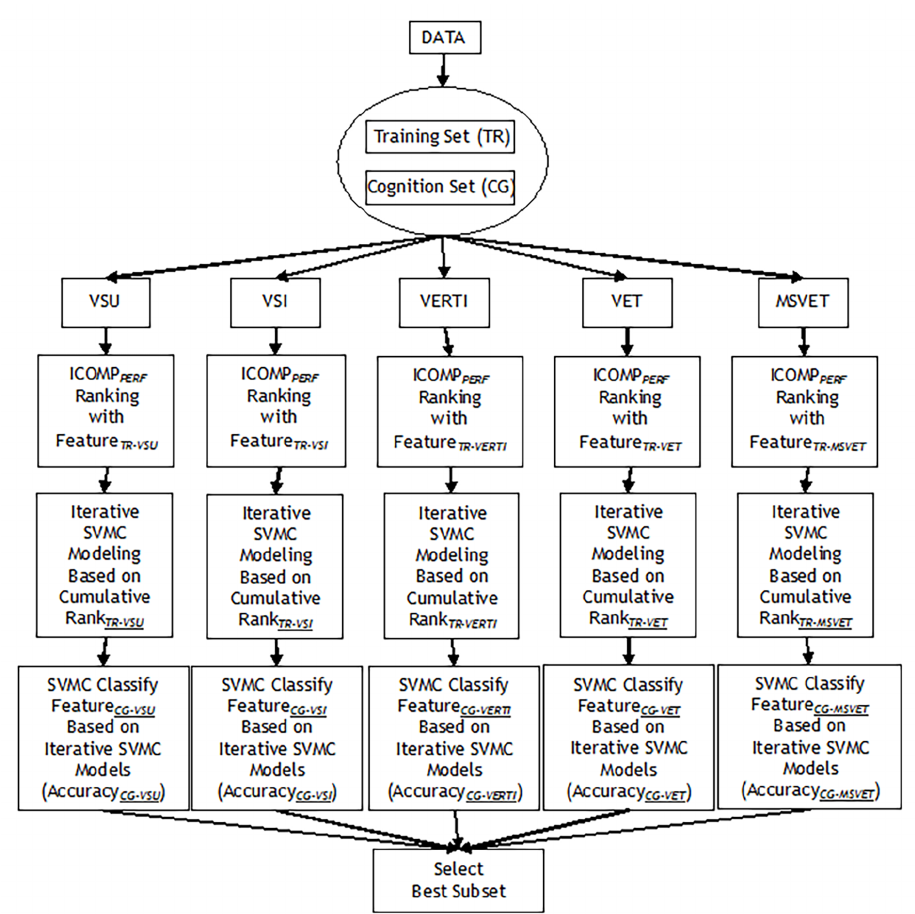
Classification Example Based on PDCM with